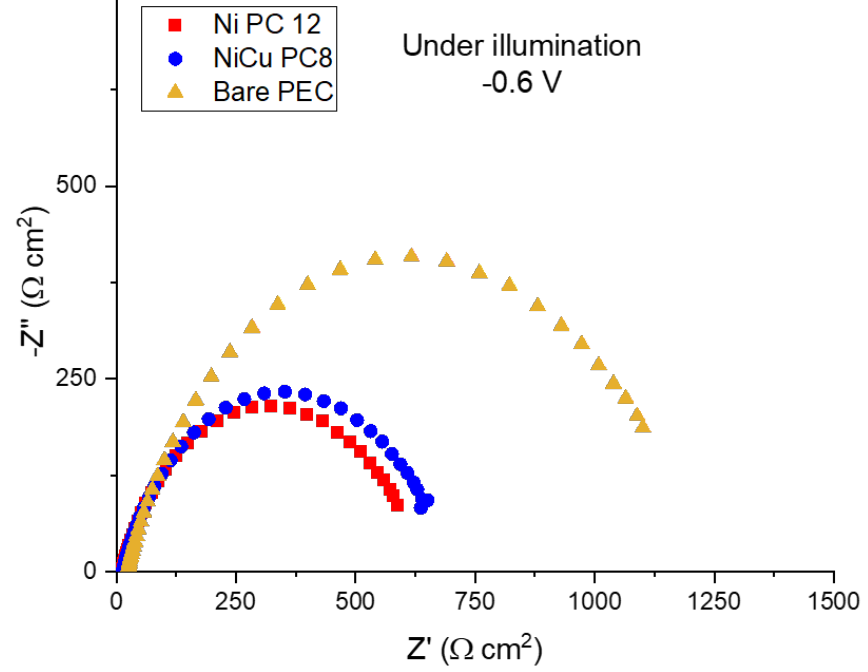
Figure 6. Impedance spectra for Ni- or NiCu-based PEC in comparison with the bare cell.